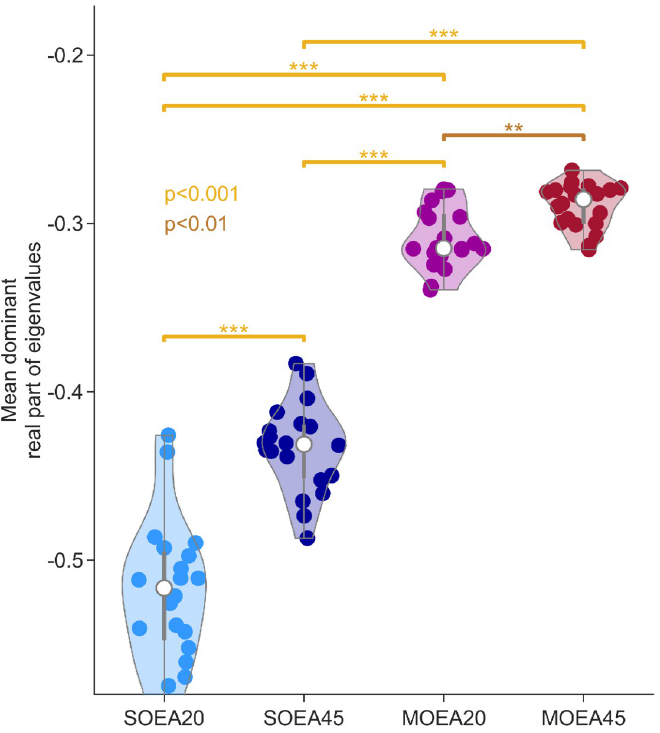
Fig 8. Distributions of the mean real part of the dominant eigenvalue for each subject across algorithms. Each point is derived from the optimal parameter set recovered from a single data set. Optimal refers to the smallest Euclidean distance from the origin in objective space. Parameters yielding unstable fixed points are excluded. P-values were obtained from a Mann-Whitney U test, with Bonferroni correction.